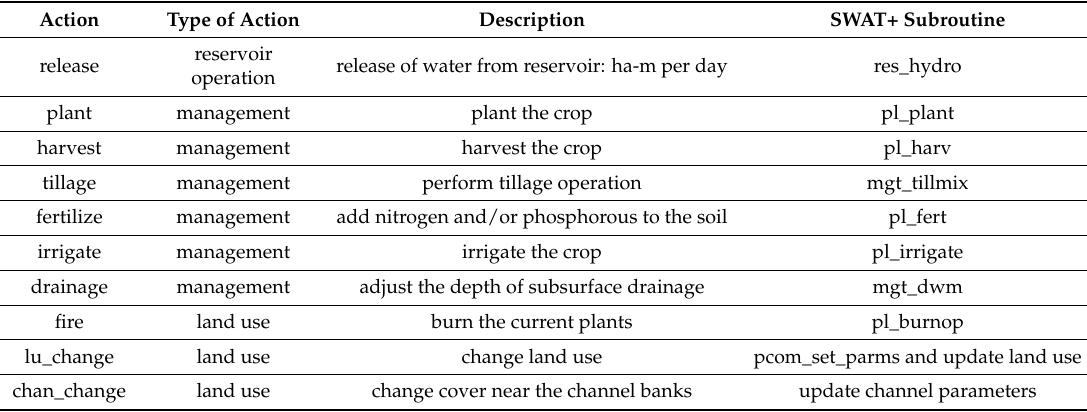
Table 3. Actions currently coded in SWAT+ for use in the decision